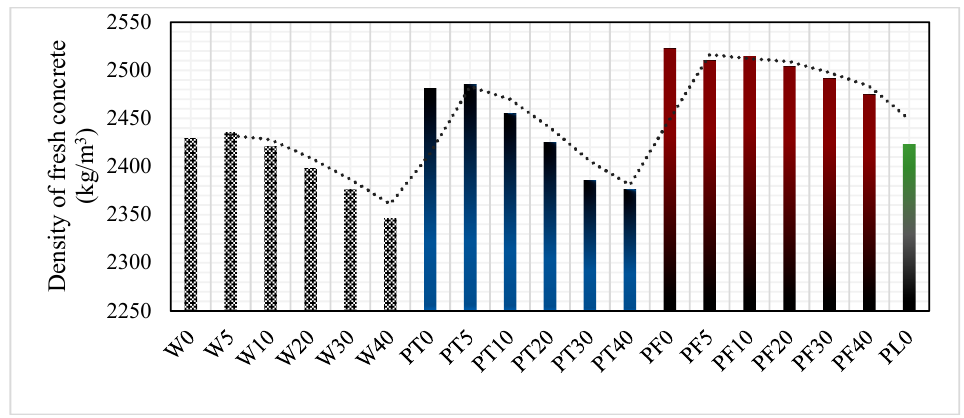
Figure 8. Fresh ‐ density of the mixes. Figure 8. Fresh-density of the